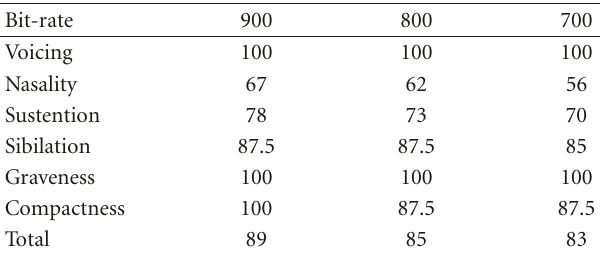
Table 6: DRT assessment